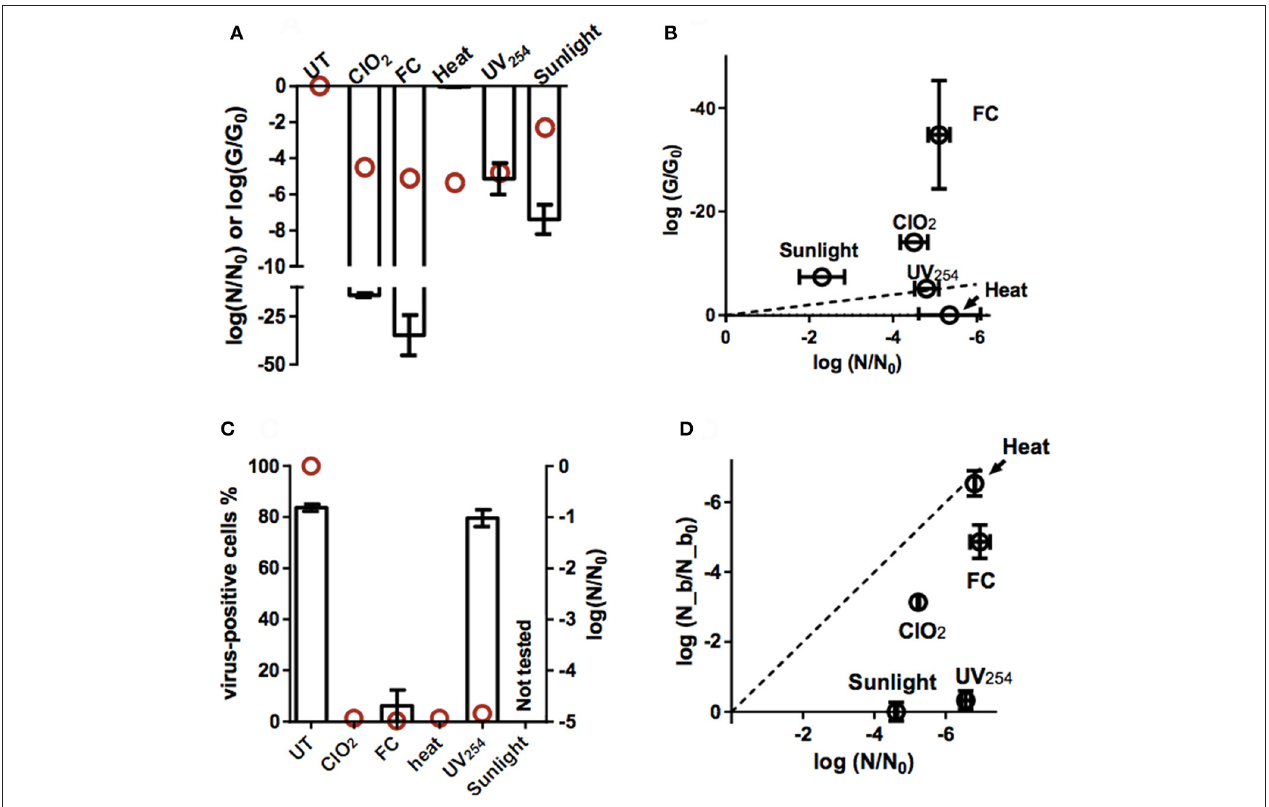
FIGURE 4 | Effect of inactivation by ClO 2 , FC, heat, UV 254, and sunlight on viral functions. (A) Loss of PCR-replicable genome upon inactivation (log( G/G 0 ); bars). Red circles indicate the corresponding loss in inactivation (log( N/N 0 )). Errors bars represent the standard deviations associated with G/G 0 ( Ku, 1966). (B) Loss of PCR-replicable genome, plotted against infectivity loss. The dashed line represents the 1:1 correlation between genome loss and infectivity loss. Errors bars represent the the MPN enumeration error (horizontal) or standard deviations associated with G/G 0 (vertical). (C) Percentage of cells with bound viruses, determined by flow cytometry (bars, left y-axis, UT: untreated E11 sample). Red circles indicate the corresponding virus infectivity loss (right y-axis). (D) Residual fraction of bound viruses (log( N_b/N_b 0 )) measured by PCR and plotted against infectivity loss. The dashed line represents the 1:1 correlation between binding loss and infectivity loss. Error bars represent the MPN enumeration error (horizontal) or range of duplicate experiments